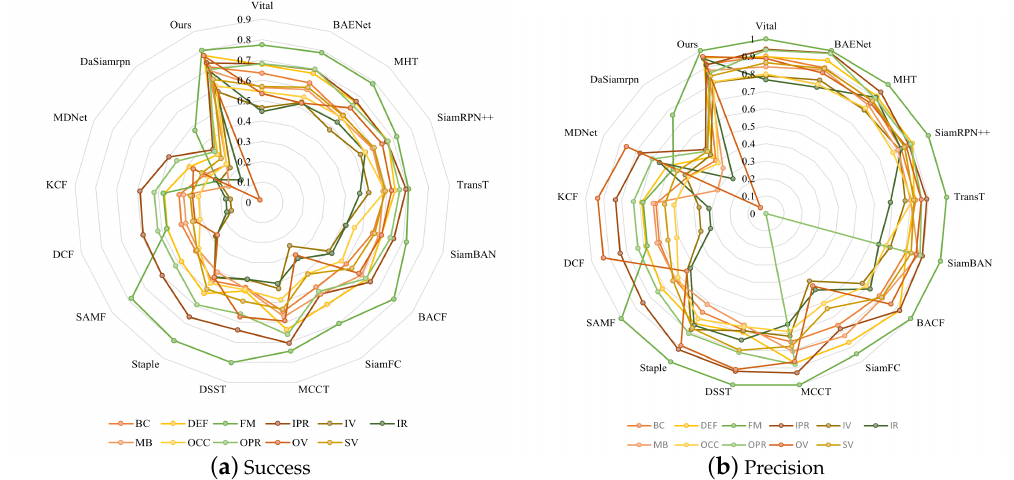
Figure 7. The proposed method compared with trackers on